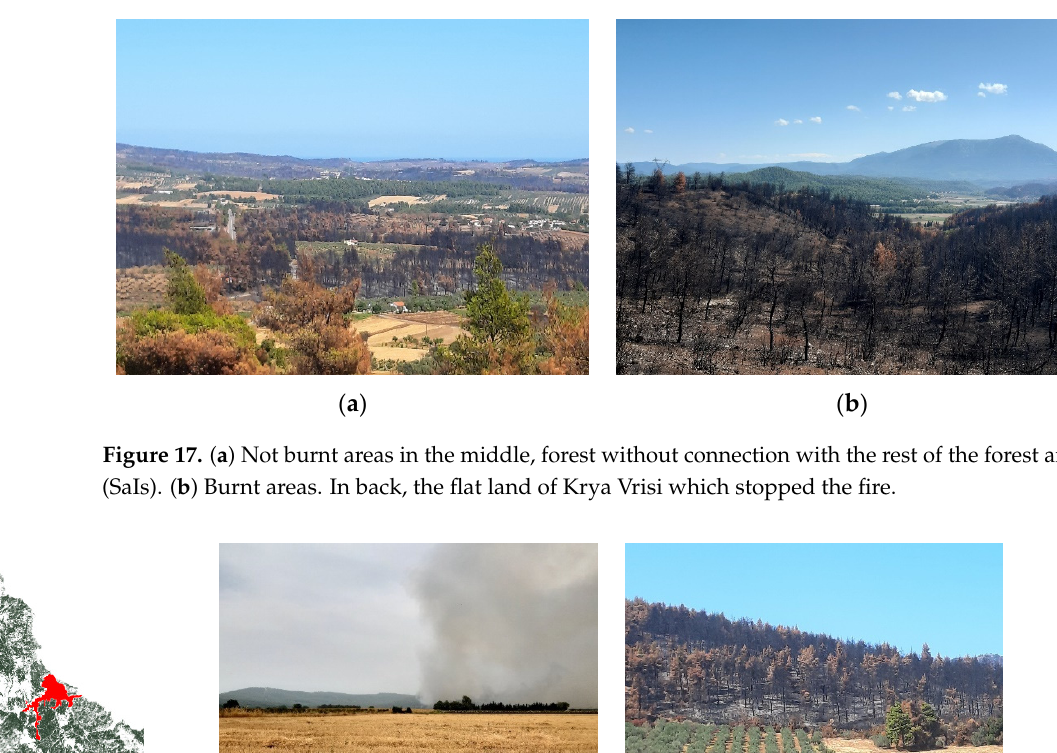
Figure 16. ( a ) Burnt area. ( b ) Burnt areas with anti ‐ fire zones.